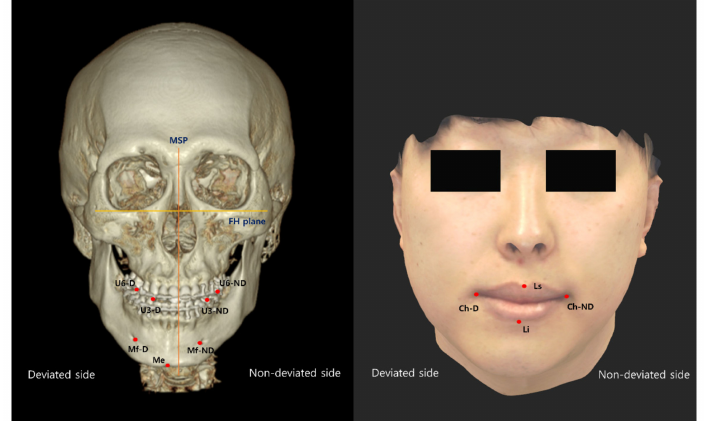
Figure 3. Hard tissue and soft tissue landmarks used in this study. MSP, midsagittal plane; U3- D/ND, maxillary canine cusp tip on the deviated side/non-deviated side; U6-D/ND, maxillary 1st molar mesiobuccal cusp tip on the deviated side/non-deviated side; Mf-D/ND, mental foramen on the deviated side/non-deviated side; Me, menton; Ls, labrale superius; Li, labrale inferius; and Ch-D/ND, cheilion on the deviated side/non-deviated